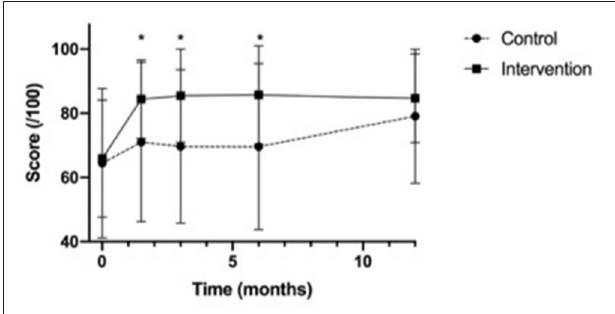
FIGURE 4 | Self-Efficacy assessment score means. *p-value < 0.05, referring to the significant difference in scores between the control and intervention groups at 6 weeks, 3 months and 6 months post-education.